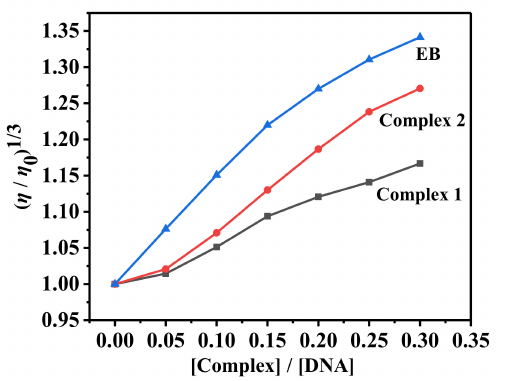
Figure 5. Impacts of increasing complex 1 /complex 2 numbers, as well as EB on relative DNA viscosity at 29.0 ± 0.1 ◦